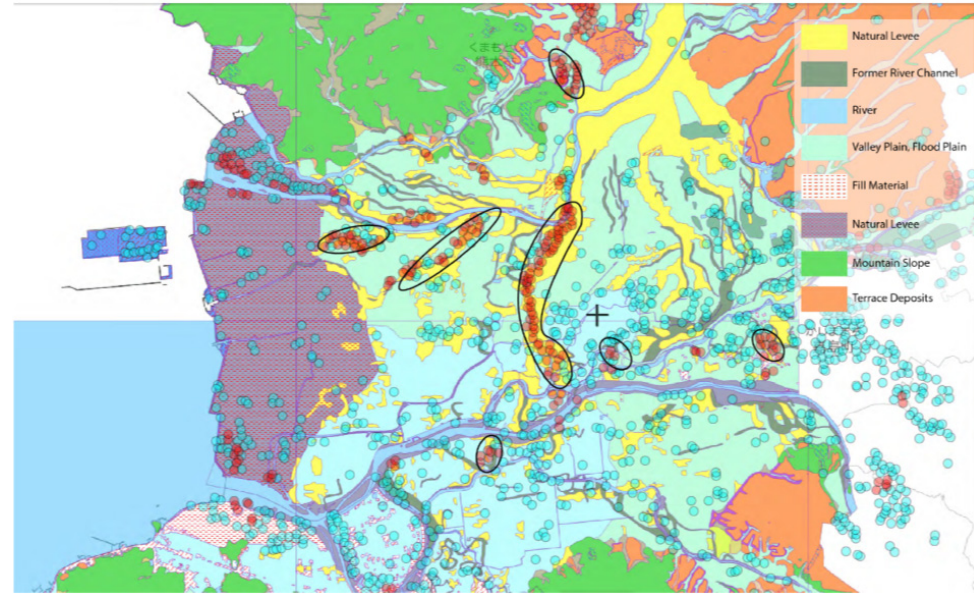
Figure 22. Kumamoto Plain geomorphological map with confirmed liquefaction sites (red). Circled sites represent former river channels and constitute the most common locations where liquefaction surface evidence was observed. Modified from [17]. After [40].